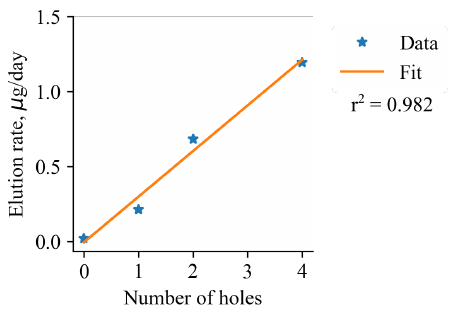
Figure 5. The linear dependence between the elution rate and the number of holes (